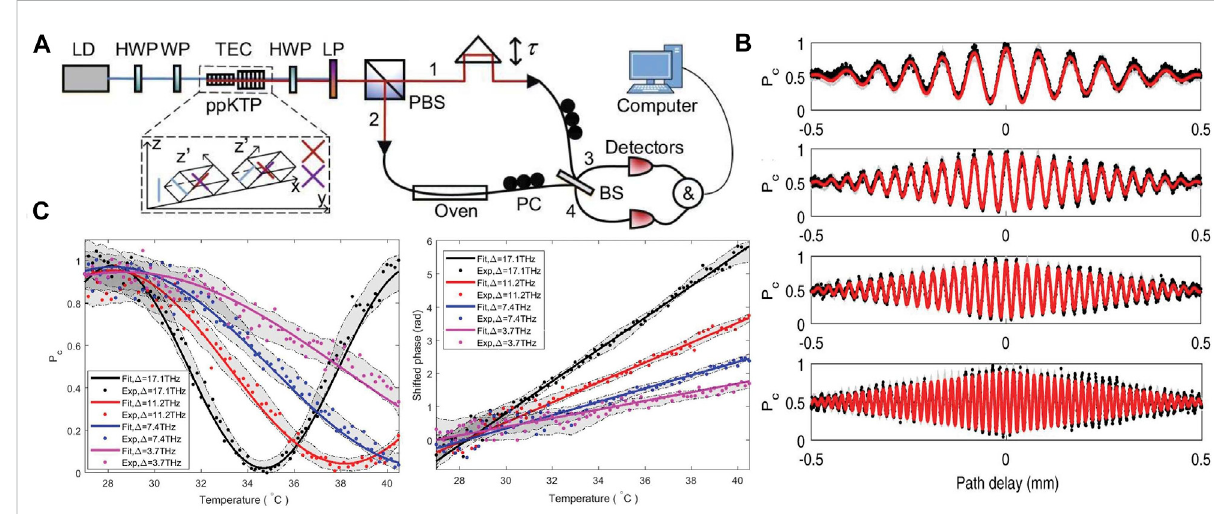
FIGURE 3 (A) Experimental setup for temperature sensor through the beating of frequency entanglement. (B) Two-photon HOM interference of frequency entanglement with various different frequency detunings such as 3.65 THz (7.98 nm) at a temperature of 30 ° C, 7.35 THz (16.08 nm) at a temperature of 50 ° C, 11.18 THz (24.45 nm) at a temperature of 70 ° C, and 17.08 THz (37.35 nm) at a temperature of 100 ° C. (C) Experimental demonstration of thermal characteristics of jacket optical fi ber by using frequency-entangled photons with various different frequencies. P c is the normalized probability of HOM interference as expressed in Eq. 6